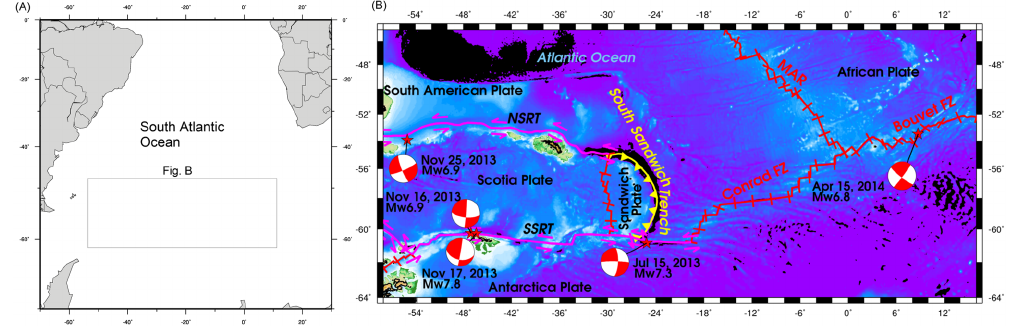
Figure 4. Earthquake events which occurred in the South Atlantic Ocean source zone: (a) overview of the source zone; (b) location of five events: three around Scotia Plate, one near the Falkland Island and another one near Bouvet Island, their focal mechanisms are strike–slip faulting (red beach ball), the subduction zone (yellow line), the transforms (magenta lines), the active spreading center and fracture zones (red lines).